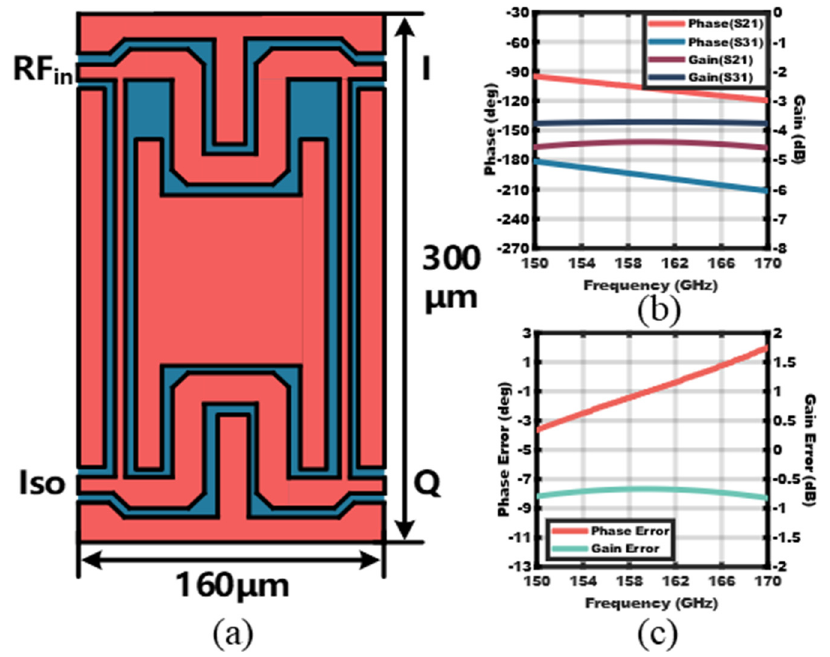
Figure 8. ( a ) Layout of the quadrature − hybrid, ( b ) simulated phase/gain response, and ( c ) simulated phase/gain error.